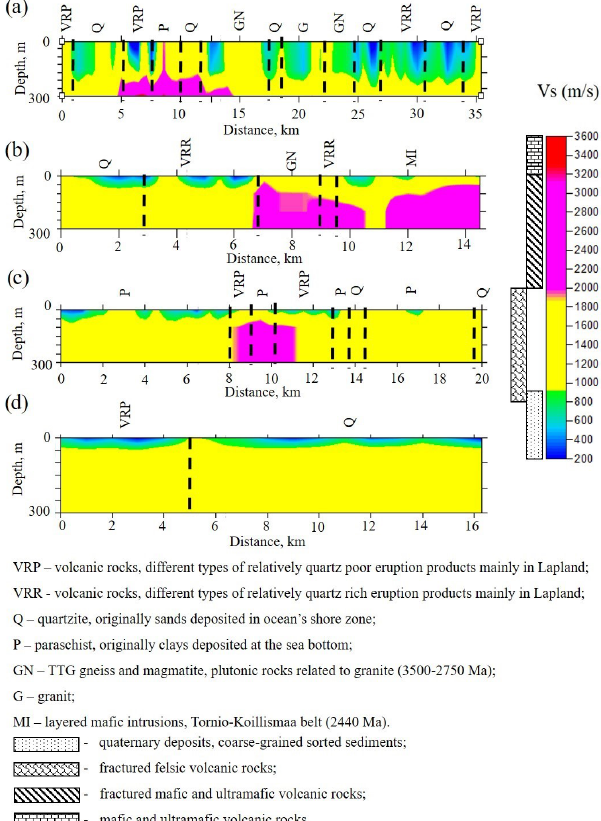
Figure 19. Velocity models presented in Fig. 18, in which possi- ble rock types are indicated by different colours. The ranges of S- wave velocities correspond to major rock types of the Fennoscan- dian Shield (Dortman, 1992): (a) Pomokairantie; (b) Alaliesintie; (c) Sakatti; (d)